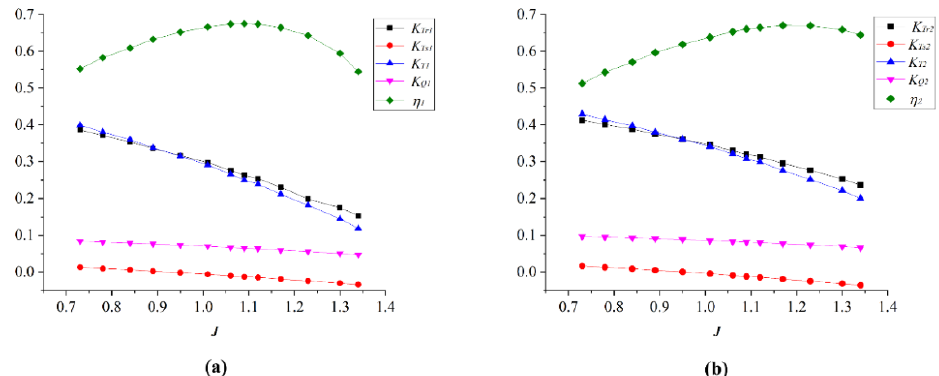
Figure 14. Hydrodynamic performance of pump-jet designed by lifting method and lifting-line method: ( a ) Lifting method; ( b ) lifting-line method.